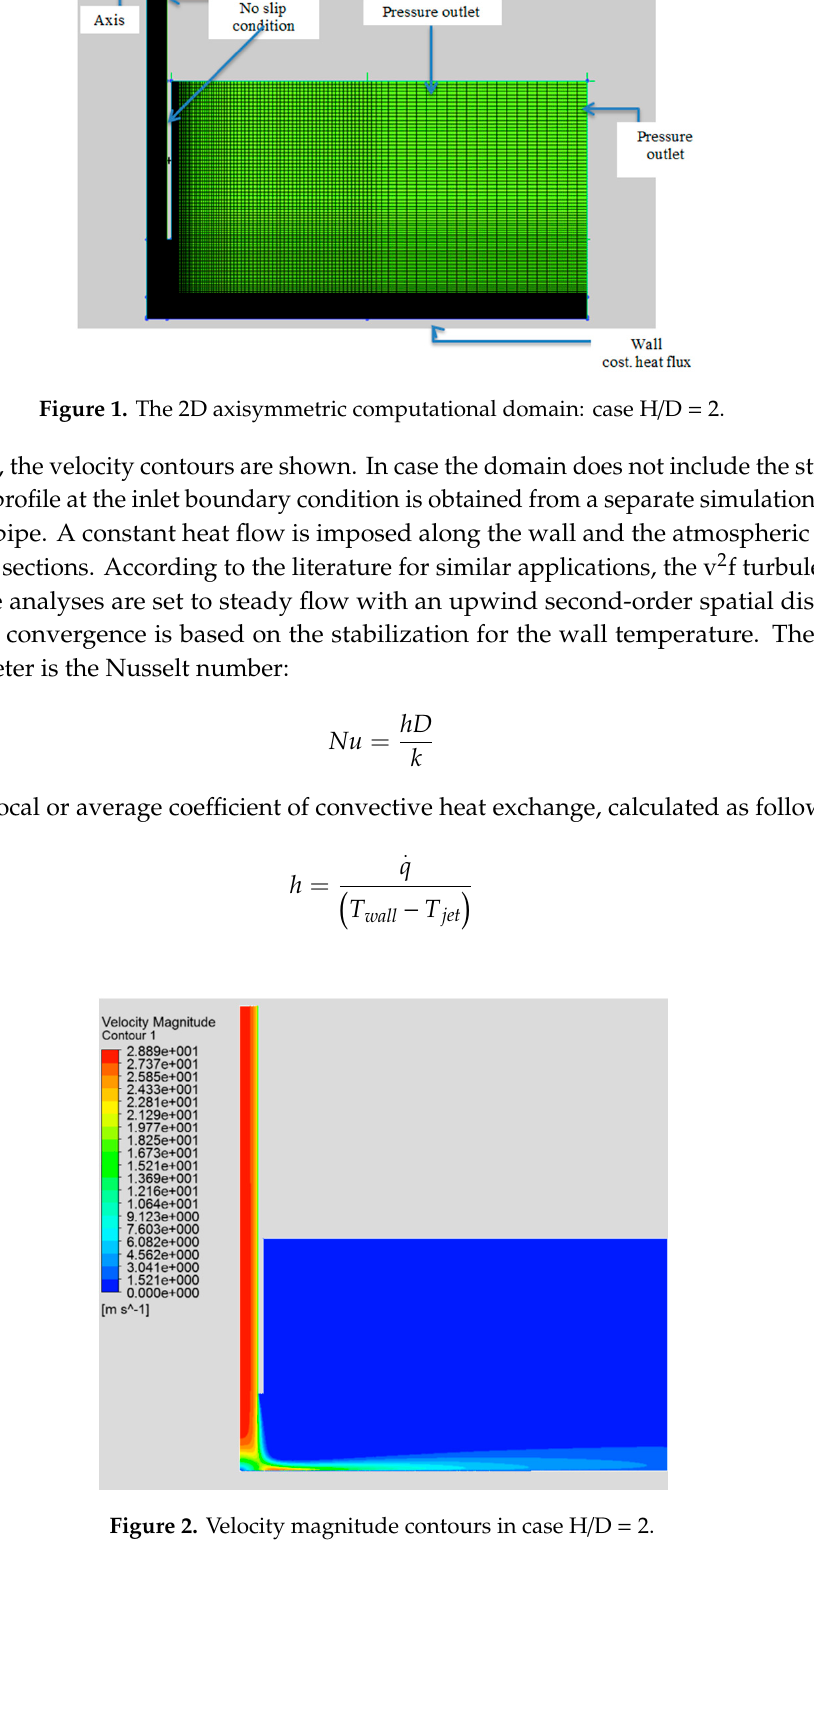
Figure 3. Nusselt number along the wall H/D = 2—CFD vs. experimental data. Figure 4. Nusselt number along the wall H/D = 6—CFD vs. experimental data. 2.2. 3D Model To check the effects of the interaction among different jets, a 3D case is analyzed: it is characterized by nine in-line jets arranged in three rows. Geers [8] experimentally investigated the same geometry considered; in Figure 5, the top view of the geometry is shown. A perforated plate generates the jet cluster; the diameter D = 13 mm, the distance s between hole centers is 52 mm, and the jet–wall distance is H = 52 mm. The dimensionless ratios H/D = 4 and s/D = 4 are obtained.